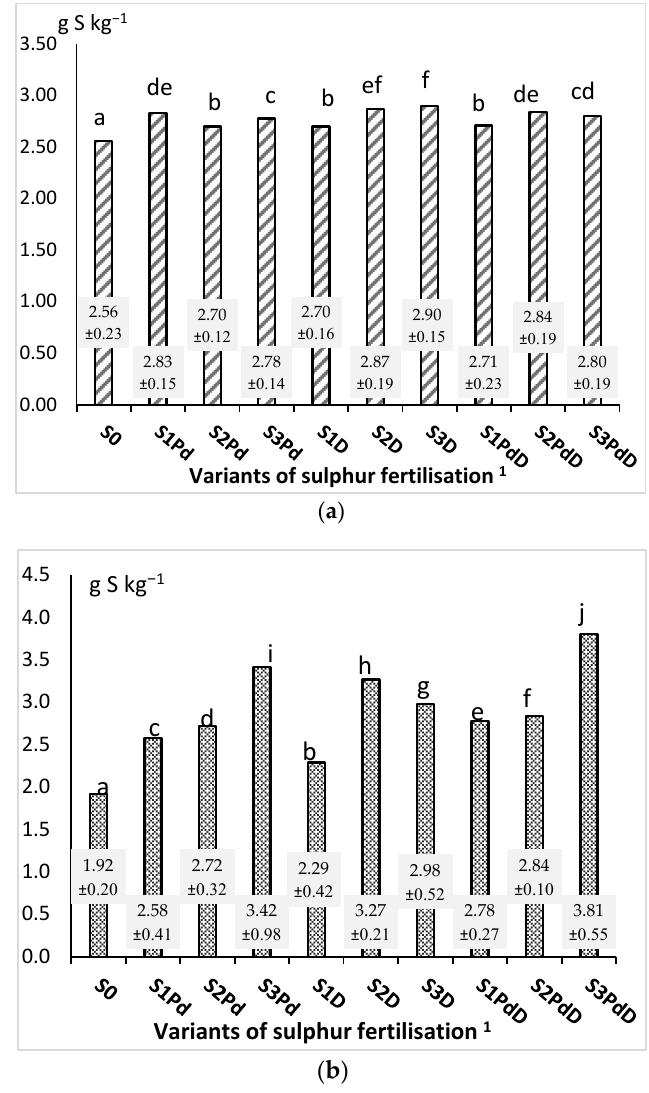
Figure 5. ( a ) Sulphur content in the rape seeds on average for variants of sulphur fertilisation; ( b ) Sulphur content in the rape straw on average for variants of sulphur fertilisation. 1 See Table 2; Means followed by the same letter are not statistically different at the α = 0.05 level. ± —standard deviation.